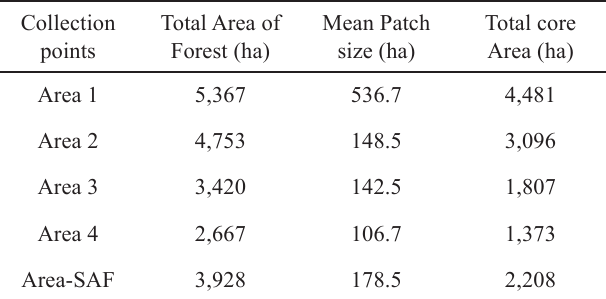
Table 3 . Landscape metric for an area of 5 Km radius around the collection points.